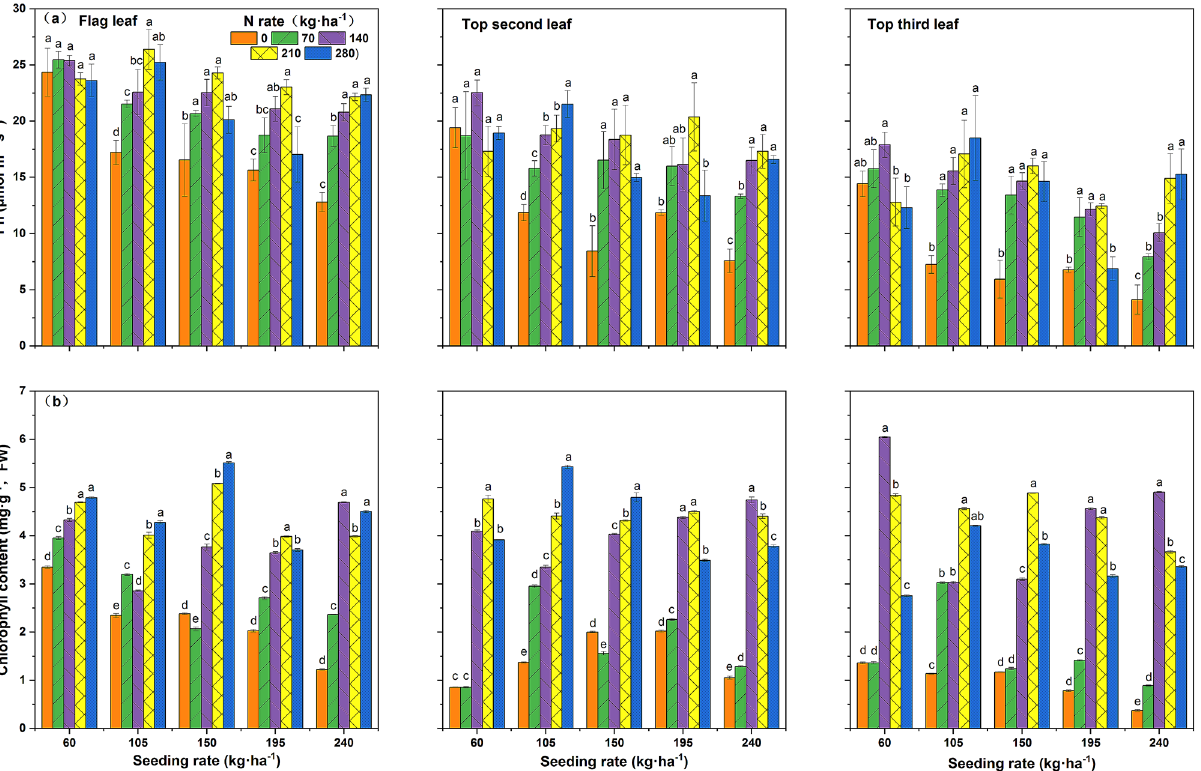
Figure 2. Effects of the interaction between seeding rate and nitrogen rate on the net photosynthetic rate and chlorophyll content for different leaf positions in the rice population 10 days after flowering under dry cultivation. ( a ) Net photosynthetic rate of the flag leaf; first second leaf and the first third leaf. ( b ) Chlorophyll content of the flag leaf; first second leaf and first third leaf. Different letters with the same sowing amount indicate significant differences at P < 0.05. The figures were prepared and combined using Origin 2018 (www. origi nlab.